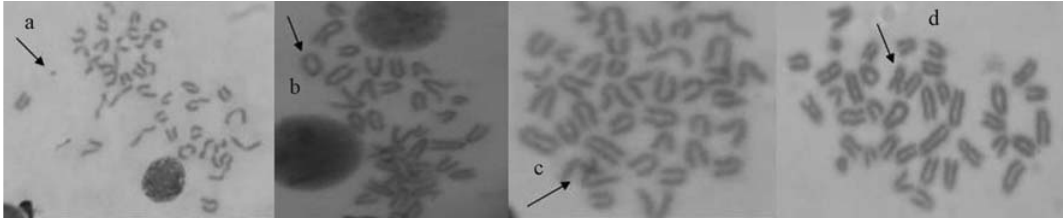
Figure 2 - Chromosomal aberrations (arrowed) induced in bone marrow cells of mice exposed to the pharmaceutical effluent. (a) chromatid break, (b) ring chromosome, (c) chromatid exchange, (d) dicentric chromosome. Magnification 1000x.